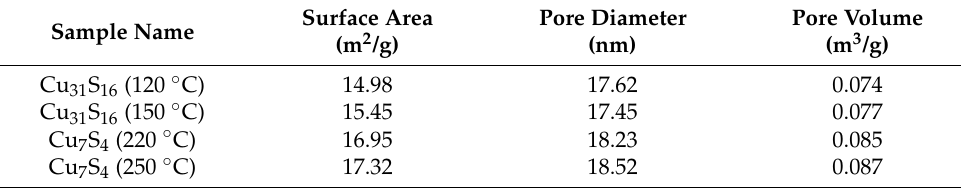
Table 1. BET analysis of copper sulfide photocatalyst